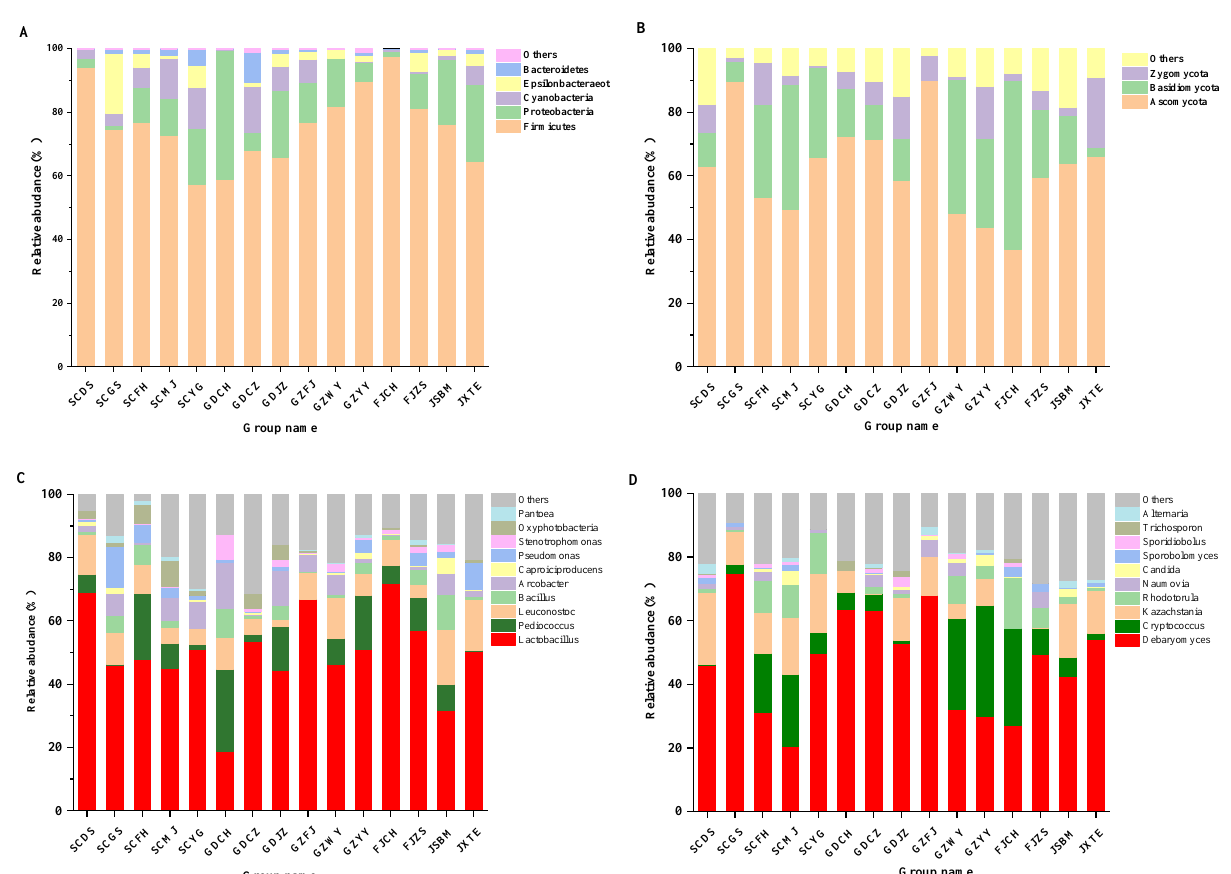
Figure 3. Microbial community in FM samples. ( A )Bacteria at the phylum level, ( B ) Fungi at the phylum level, ( C ) Bacteria at the genus level, ( D ) Fungi at the genus level.